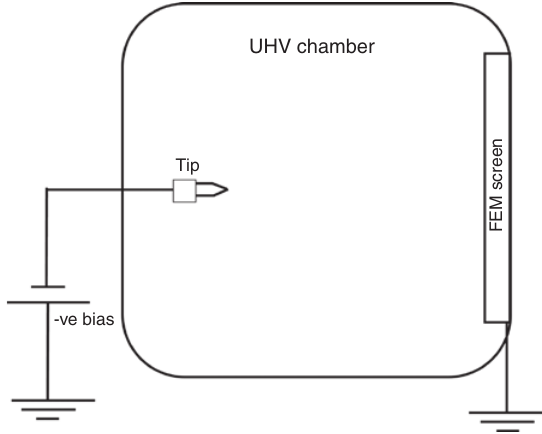
Figure 1: Schematic of an